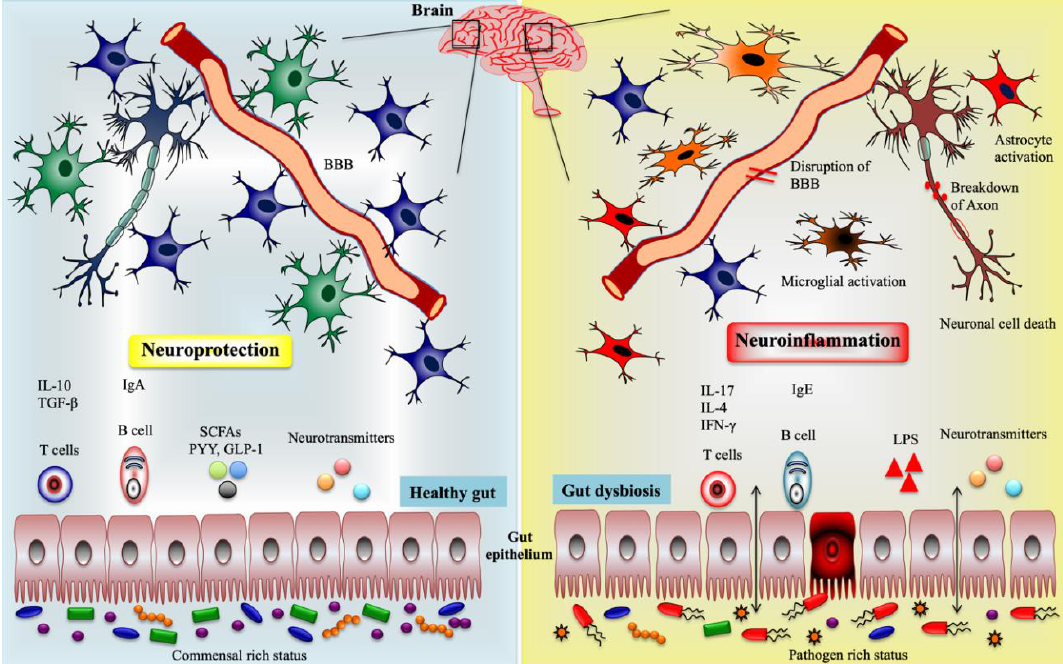
Figure 2. Influence of immune and metabolic regulation by the gut microbiota during the healthy and gut dysbiosis state via gut – brain axis. (Left side) The gut microbiota promote the production of short-chain fatty acids (SCFAs), gut-derived peptides, neurotransmitters, and regulatory T and B cells through interactions with intestinal immune cells. Along with this, the microbiota maintain intestinal permeability, decrease the production and translocation of lipopolysaccharides (LPS) to the periphery, reduce the blood – brain barrier BBB disruption, activate brain immune and neuronal cells, and improve brain functions. (Right side) Gut microbiota exhibit the opposite role to induce inflammatory state during the dysbiosis condition. Microbiota increase inflammatory T and B cells, LPS, and proinflammatory cytokines production and reduce the SCFAs level, thereby inducing the BBB permeability, activation of microglial cells and astrocytes, and neuroinflammation. Peptide YY (PYY), glucagon-like peptide-1 (GLP-1), and transforming growth factor- β (TGF- β ).